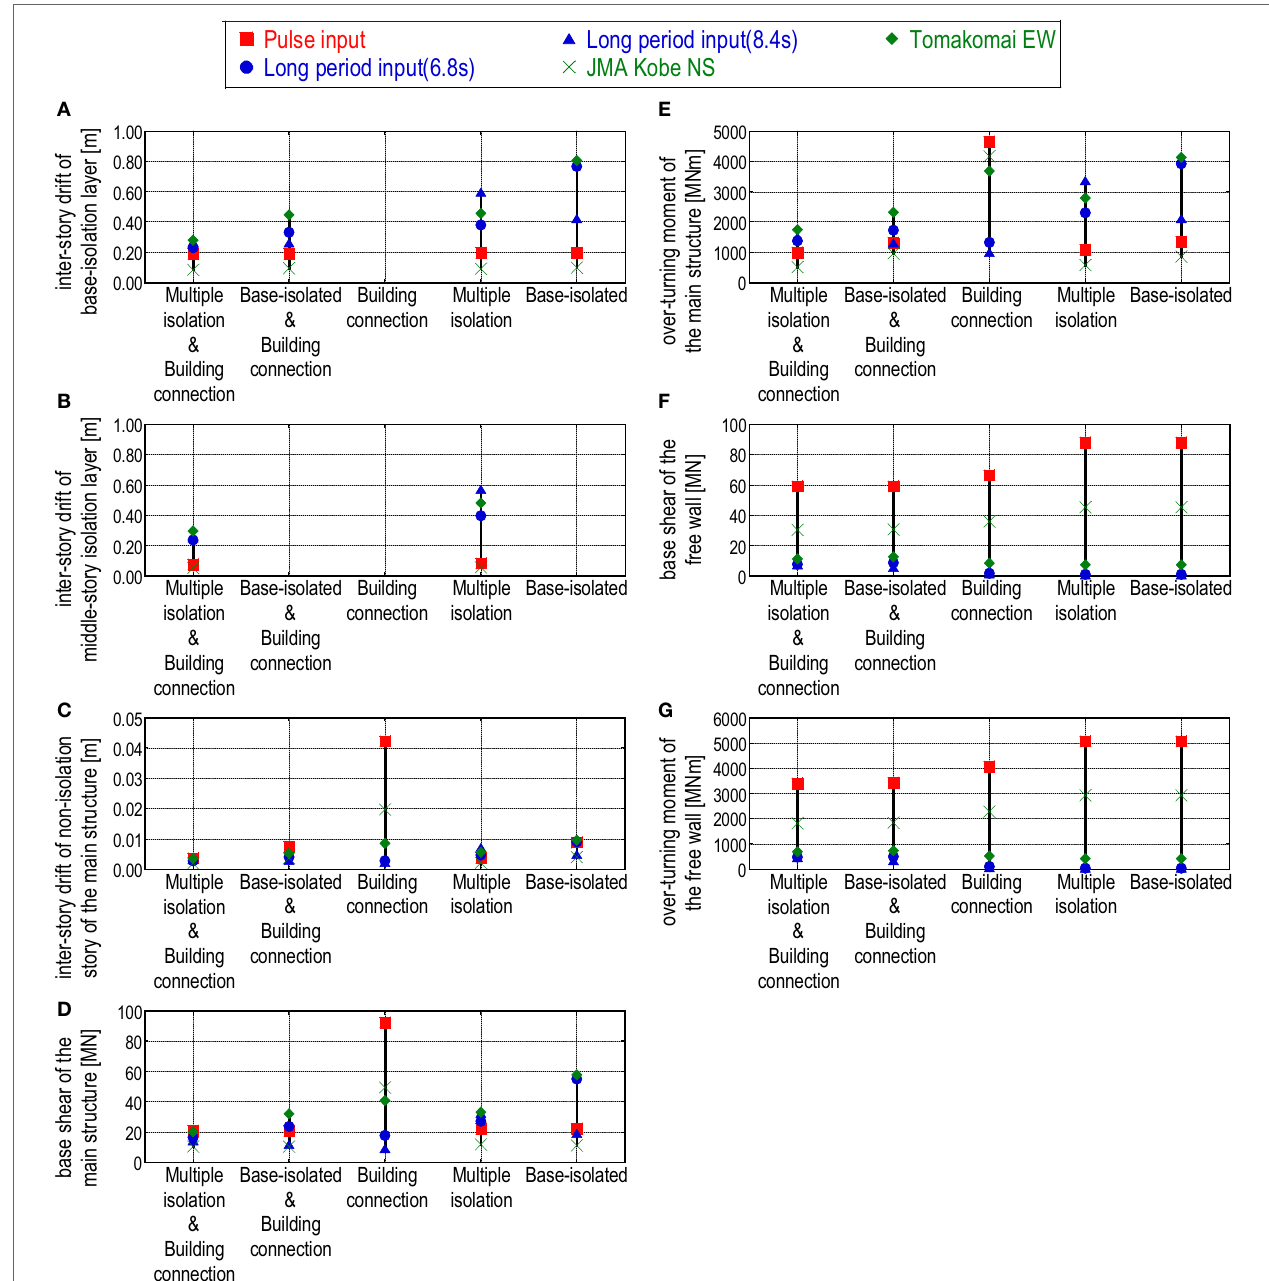
FIGURE 12 | Response variability of proposed building model and other comparable models under various earthquake ground motions: (A) inter-story drift of base-isolation layer, (B) inter-story drift of middle-story isolation layer, (C) inter-story drift of non-isolation story of the main structure, (D) base shear of the main structure, (E) base overturning moment of the main structure, (F) base shear of the free wall, and (G) base overturning moment of the free wall